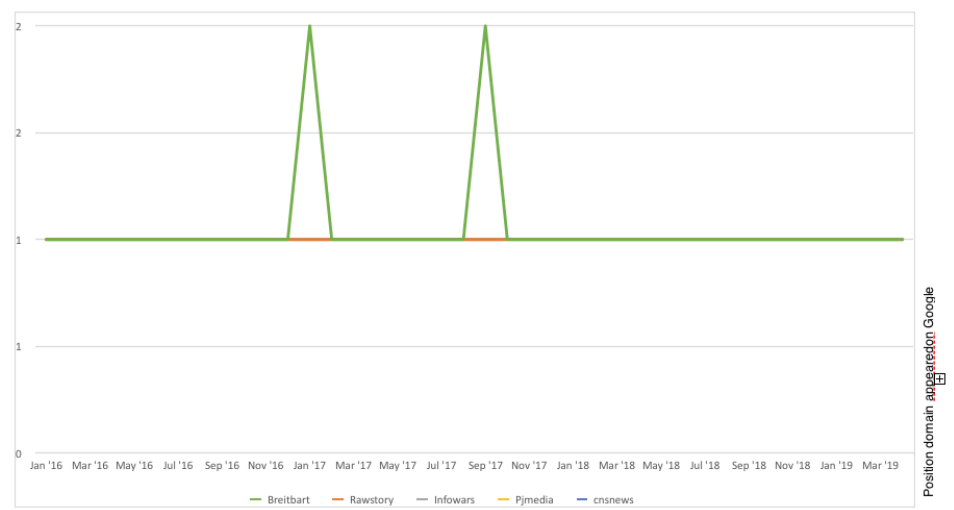
Figure 3: the performance of brand-related keywords overtime: top-5 junk news websites (January 2016-March